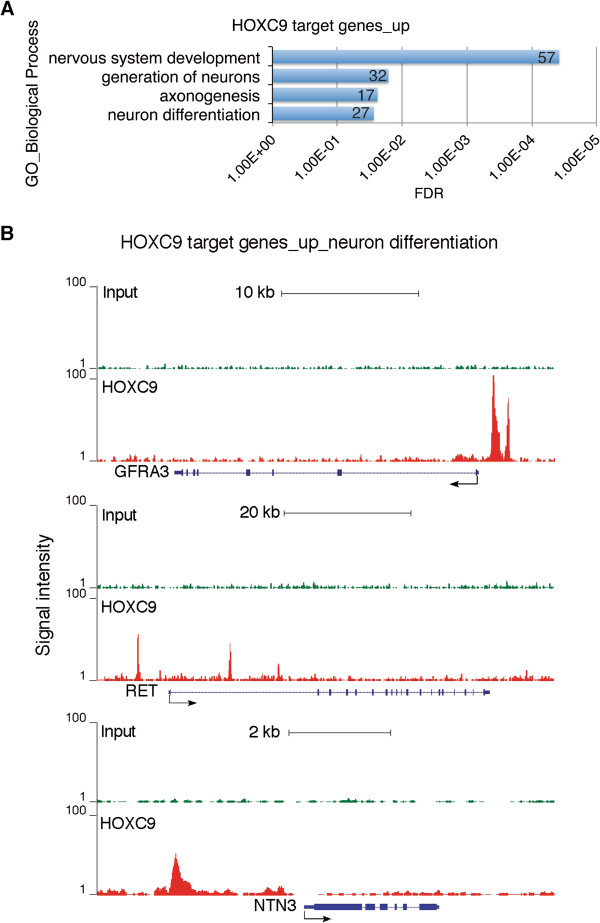
HOXC9 directly induces a large number of neuronal genes. (A) DAVID analysis of upregulated HOXC9 target genes for enriched GO biological process categories (enrichment fold > 2.0; FDR < 5%). The number of genes for each biological process category is indicated. (B) ChIP-seq tag profiles showing HOXC9 binding to representative upregulated HOXC9 target genes involved in nervous system development (GFRA3, top; RET, middle; NTN3, bottom).